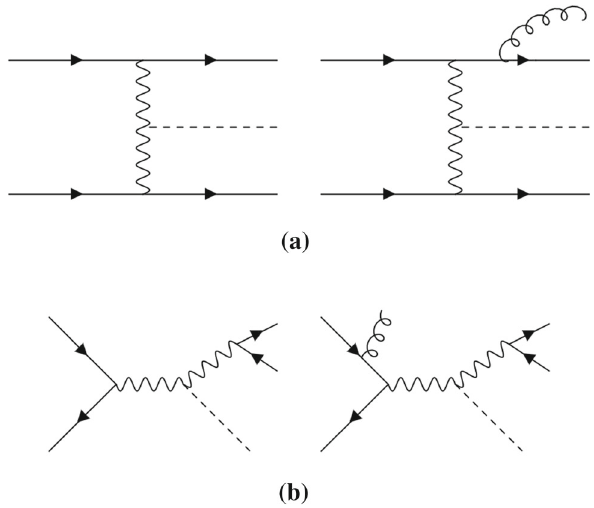
Fig. 1 Feynman diagrams for t -channel (top) and s -channel (bottom), where solid arrowed lines represent quarks, dotted line denotes Higgs boson, wavy lines are electroweak bosons, and curly lines are gluons